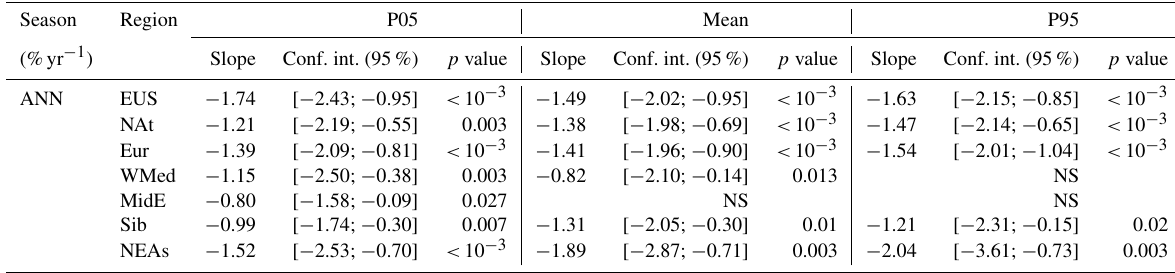
Table D7. CO relative trends in %yr − 1 during all the year in the UT. From left to right, the anomalies are taken from deseasonalized P05, monthly means, and P95. The insignificant trends with respect to the 95% confidence level are indicated as NS.